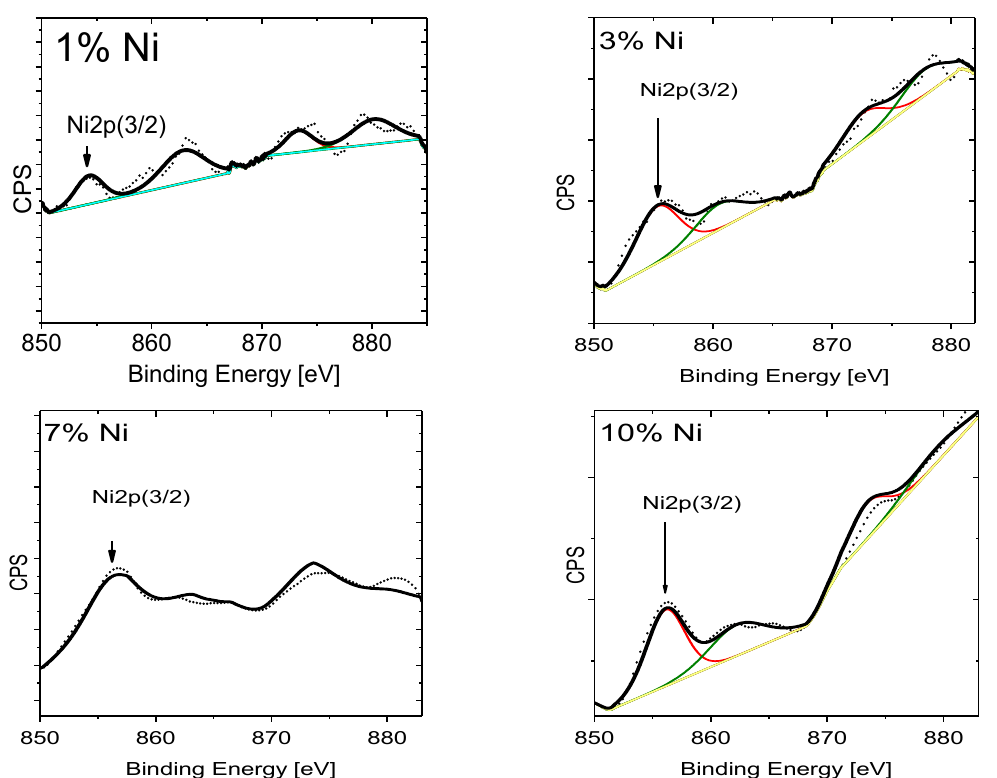
Figure 8. High-resolution XPS spectra are plotted for the Ni 2p photoelectrons. XPS is recorded for the ZnNiO samples containing 1%, 3%, 7% and 10% Ni weight percentages.